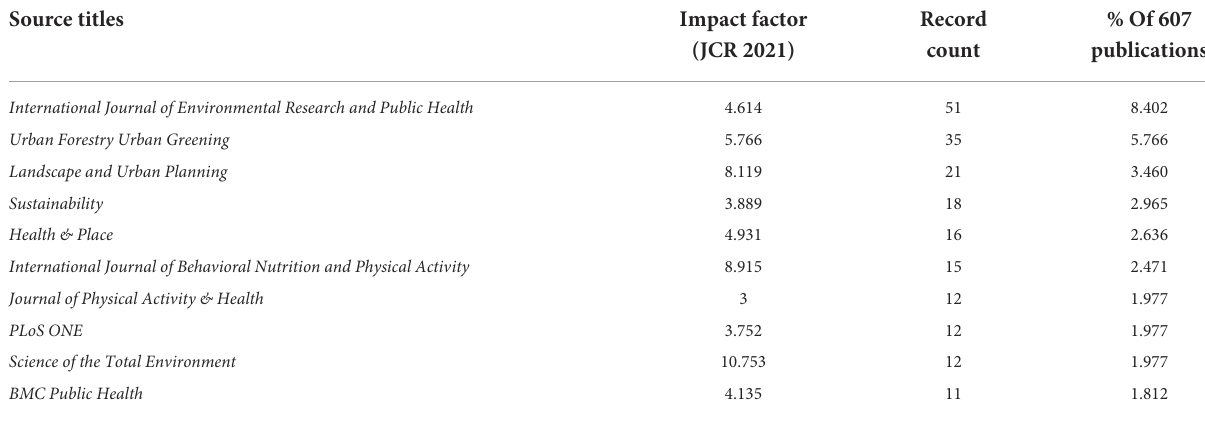
TABLE 1 Top 10 productive source publications.